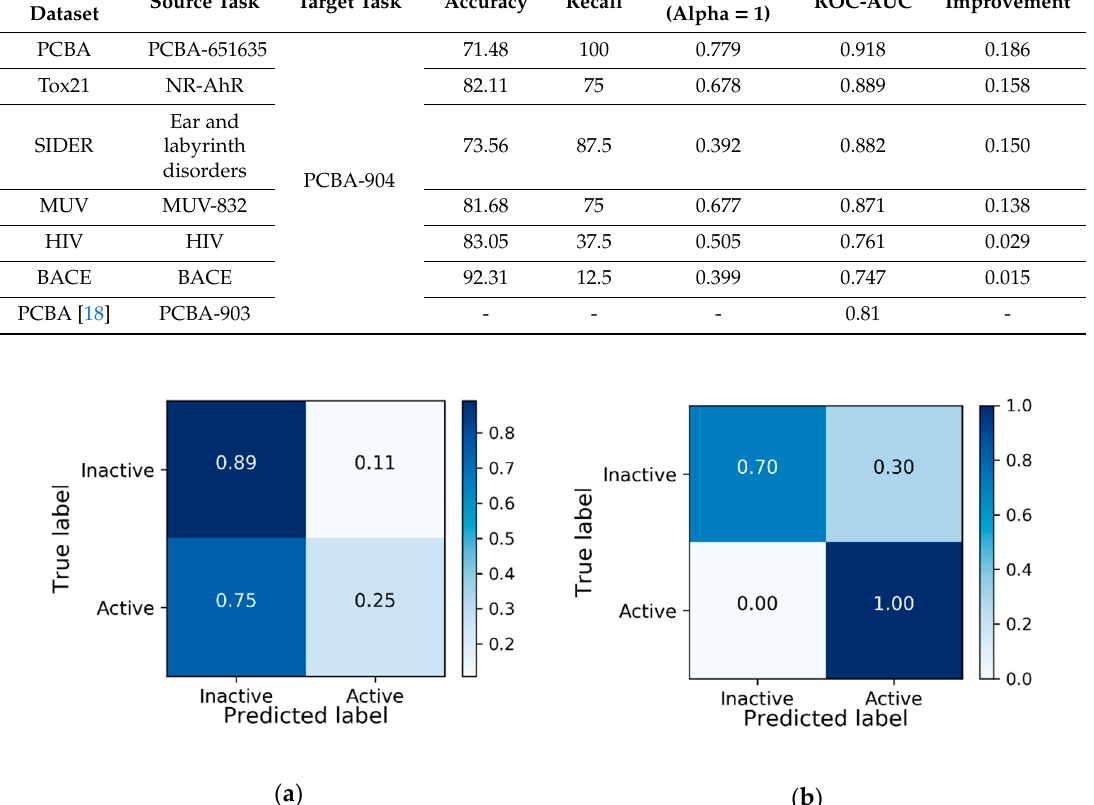
Figure 5. Confusion matrix comparison between: ( a ) baseline model; ( b ) best performing model after transfer learning.